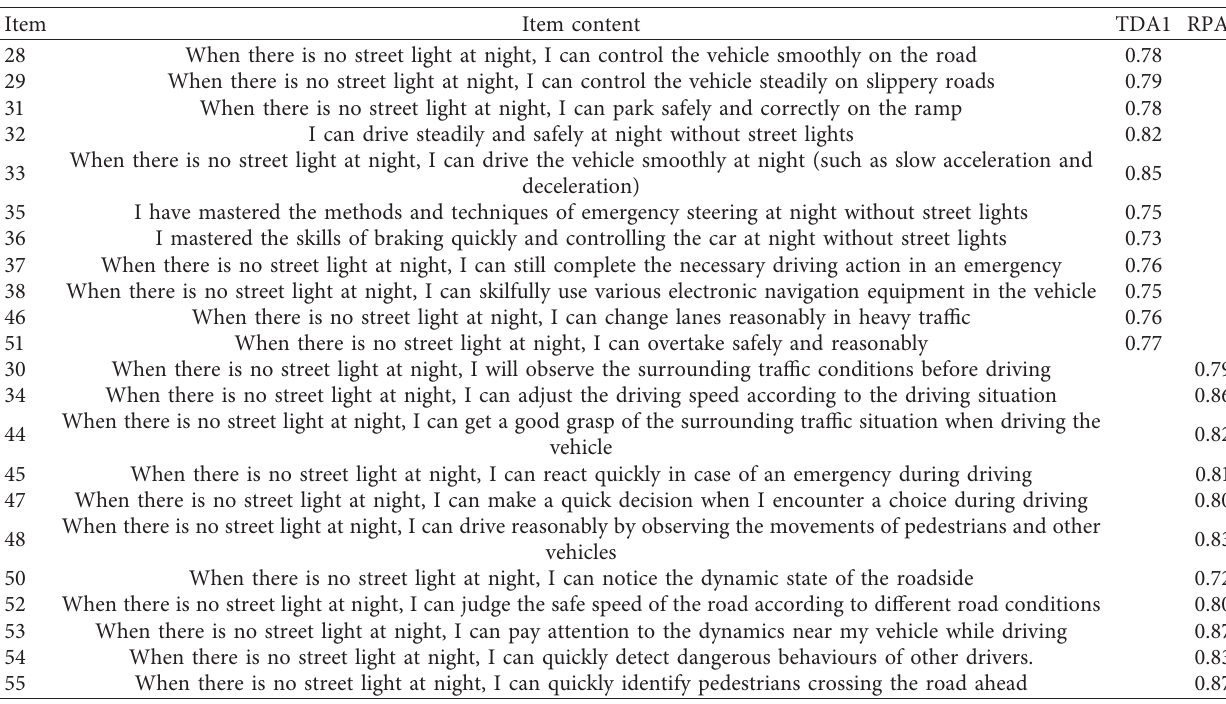
Table 2: Factor structure and load of the driving ability scale in environments with no street lights at night. Item Item content